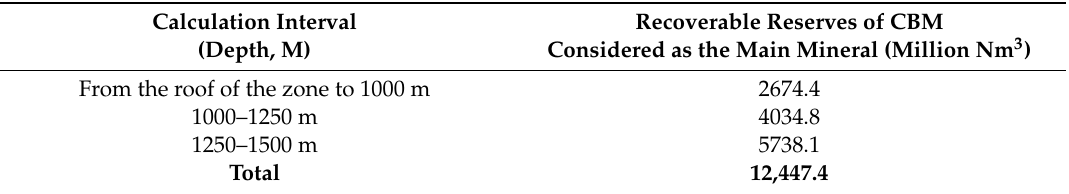
Table 6. Recoverable reserves of CBM considered as the main mineral in the second prospective region. Calculation Interval Recoverable Reserves of CBM (Depth, M) Considered as the Main Mineral (Million Nm 3 ) From the roof of the zone to 1000 m